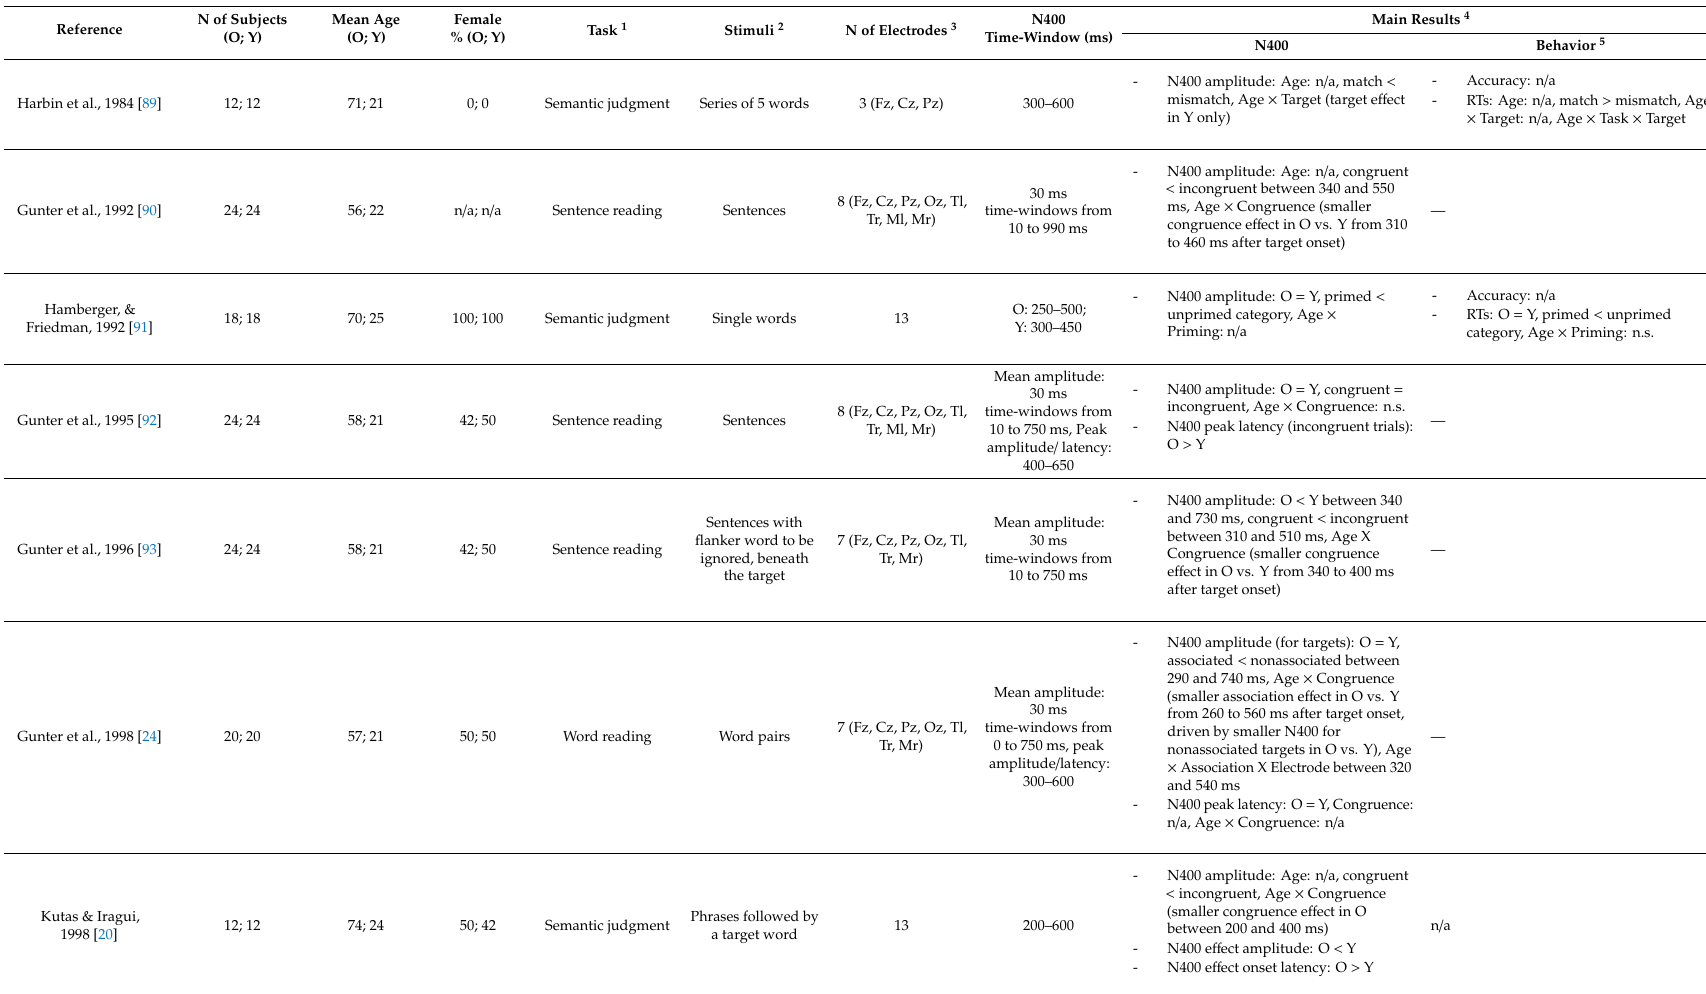
Table A1. Main characteristics of participants, materials and procedures and results of each study including older and younger groups of participants.